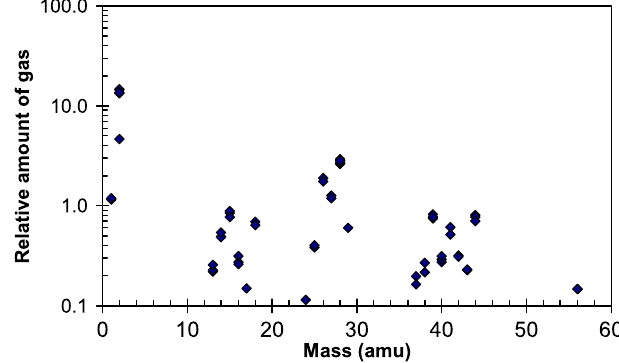
FIG. 5. (Color) Zero-time intercepts of the fast RGA signals as a function of atomic mass number